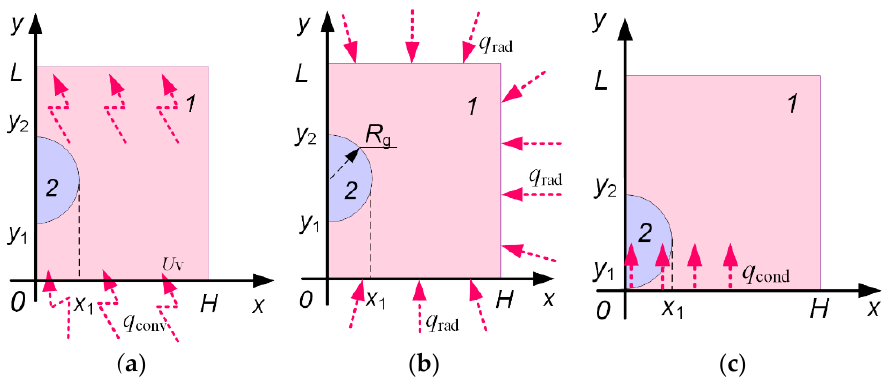
Figure 1. A scheme of the solution domain for different heat exchange schemes: ( а ) convective; ( b ) radiant; ( c ) conductive. Nomenclature: 1—gas medium; 2—hydrate particle.